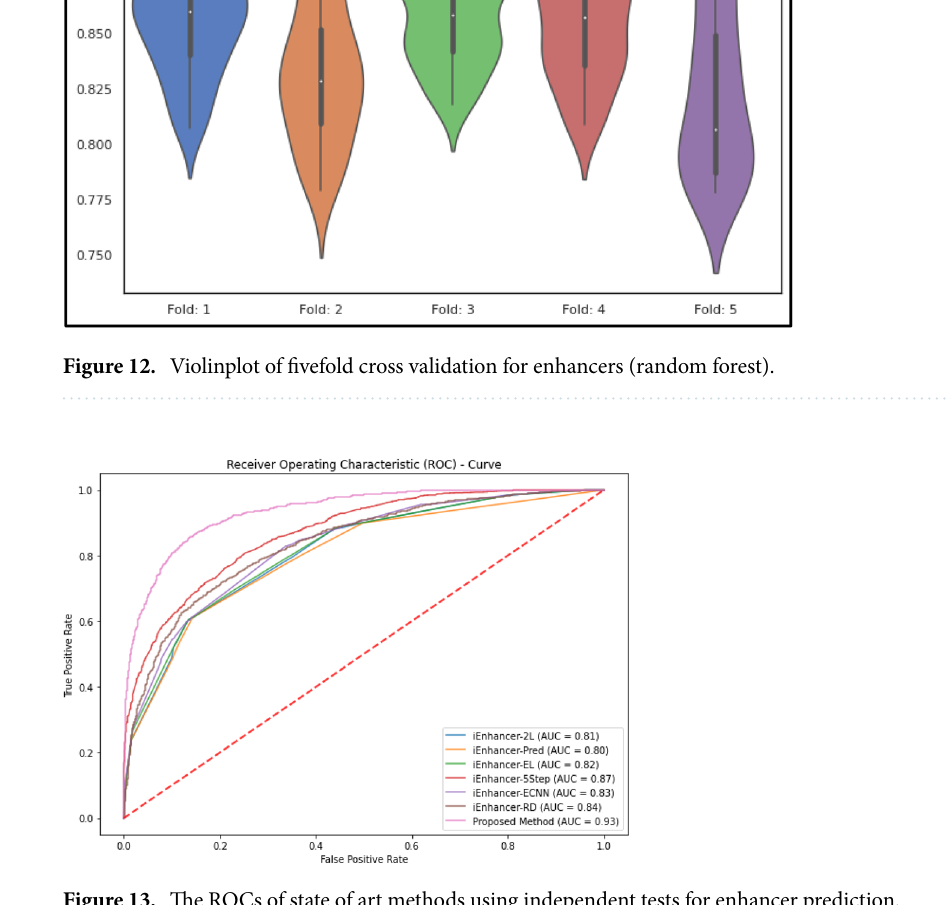
Figure 13. The ROCs of state of art methods using independent tests for enhancer prediction.